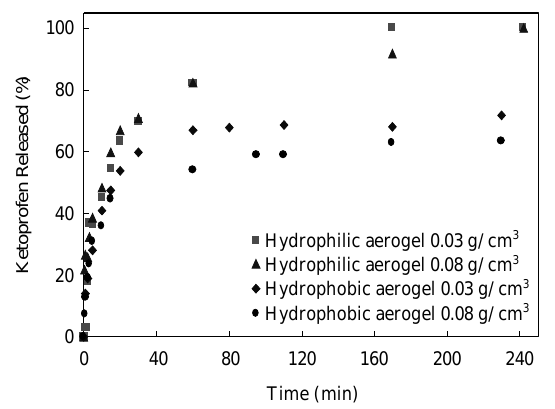
Release of ketoprofen from hydrophilic and hydrophobic aerogels of different densities in 0.1 N HCl at